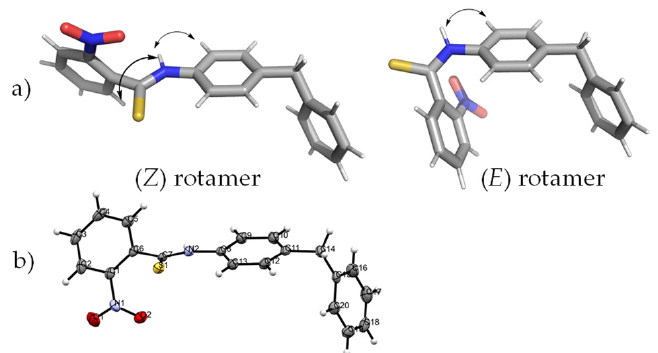
Figure 5. ( a ) ( Z ) and ( E ) rotamers of compound 1 and their NOESY correlation (structures were obtained with PyMOL ( b ) ORTEP representation of compound 1 .